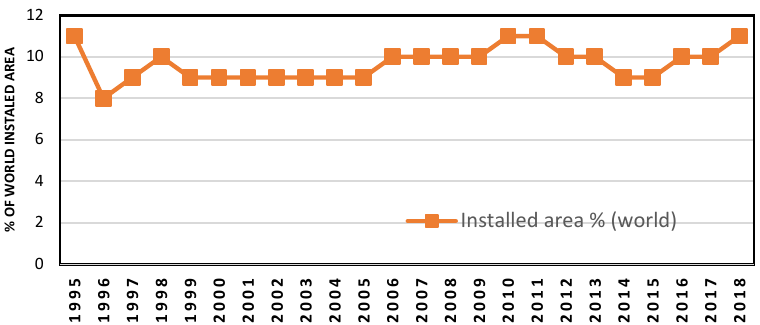
Figure 2. Evolution of the accumulation of the installed area in Morocco (% from the total in world).